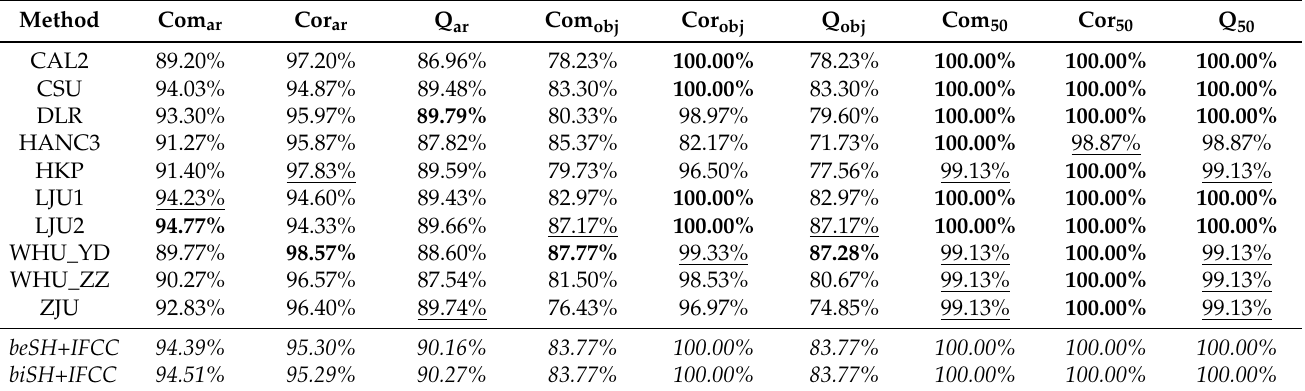
Table 6. Comparisons with the publicly available evaluation results on the ISPRS benchmark website.